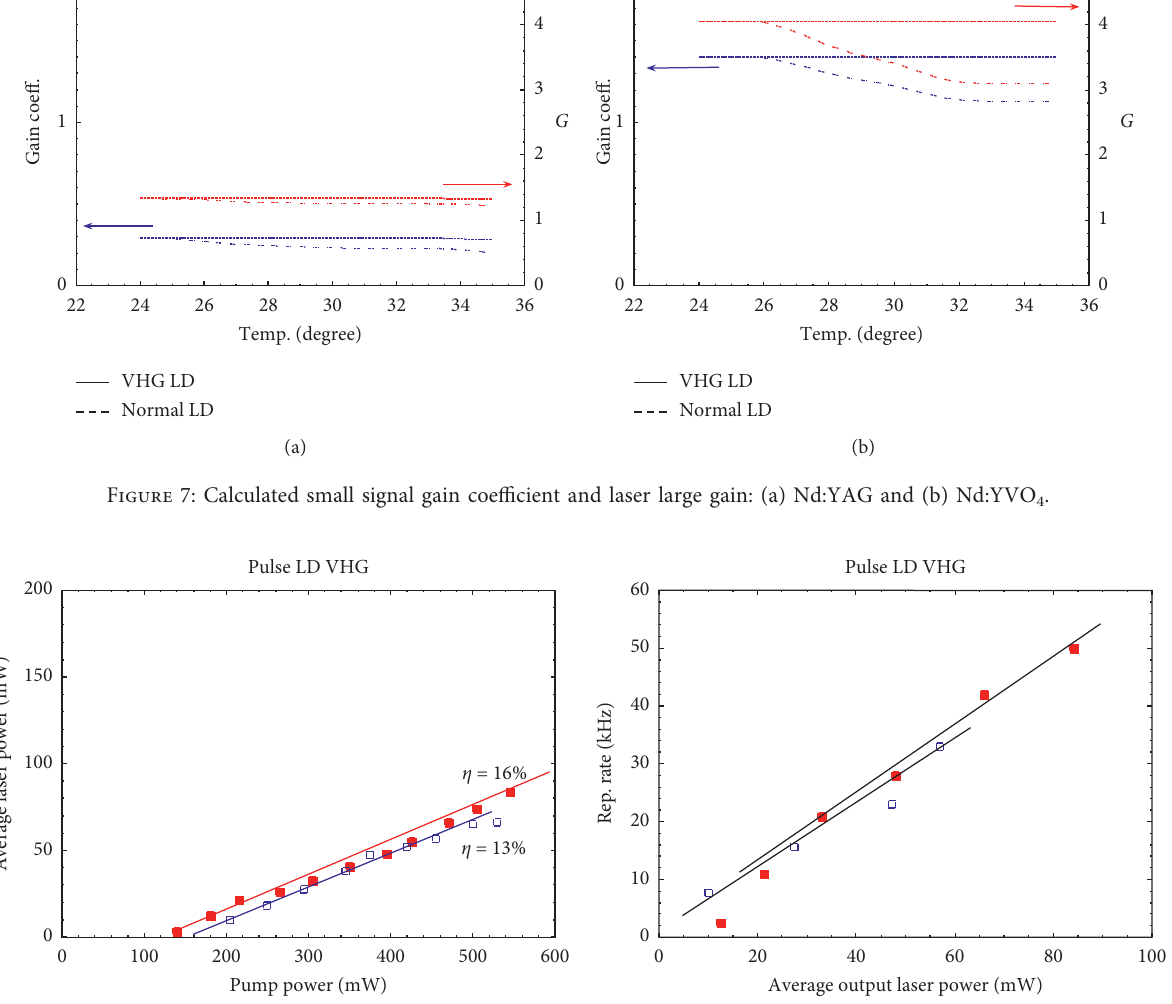
Figure 8: Nd:YAG laser under pulse operation: (a) average output laser power and (b) repetition